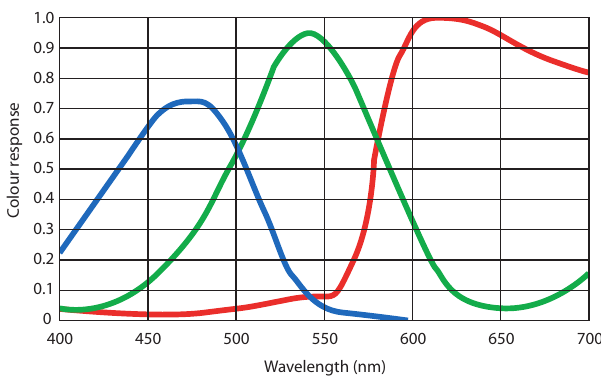
Fig. 3. Colour responses of the wide-band blue, green and red (max- ima left to right) channel of the Bayer colour matrix. These curves are reconstructed from the data sheet given by the